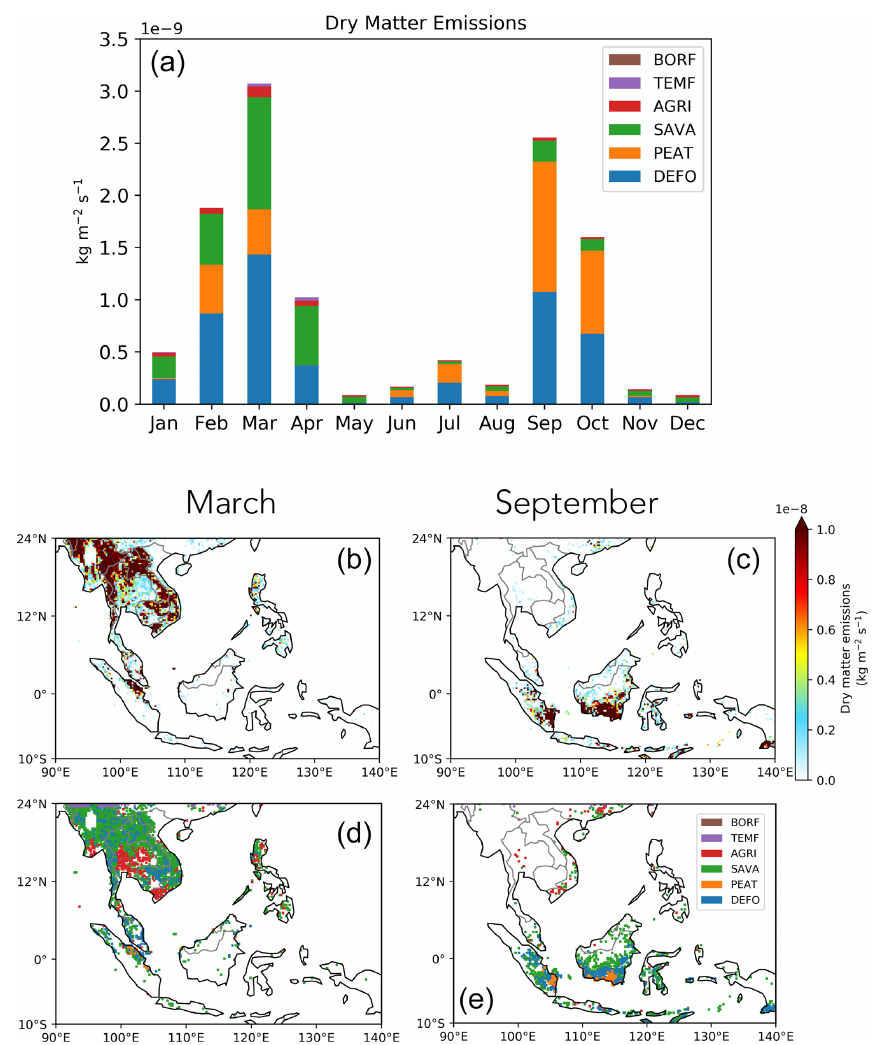
Figure 2. Monthly dry matter emissions (kgm − 2 s − 1 ) for Southeast Asia in 2014, as estimated by the GFED4.1s biomass burning inventory. (a) Time series of dry matter emissions. (b, c) Spatial distribution of dry matter emissions in March and September. (d, e) Map of the predominant vegetation types burned in March and September. Vegetation types shown in (a, d, e) include deforestation (DEFO), peat (PEAT), savanna (SAVA), agricultural waste (AGRI) and temperate forest (TEMF). There are no emissions from boreal forests (BORF) in this